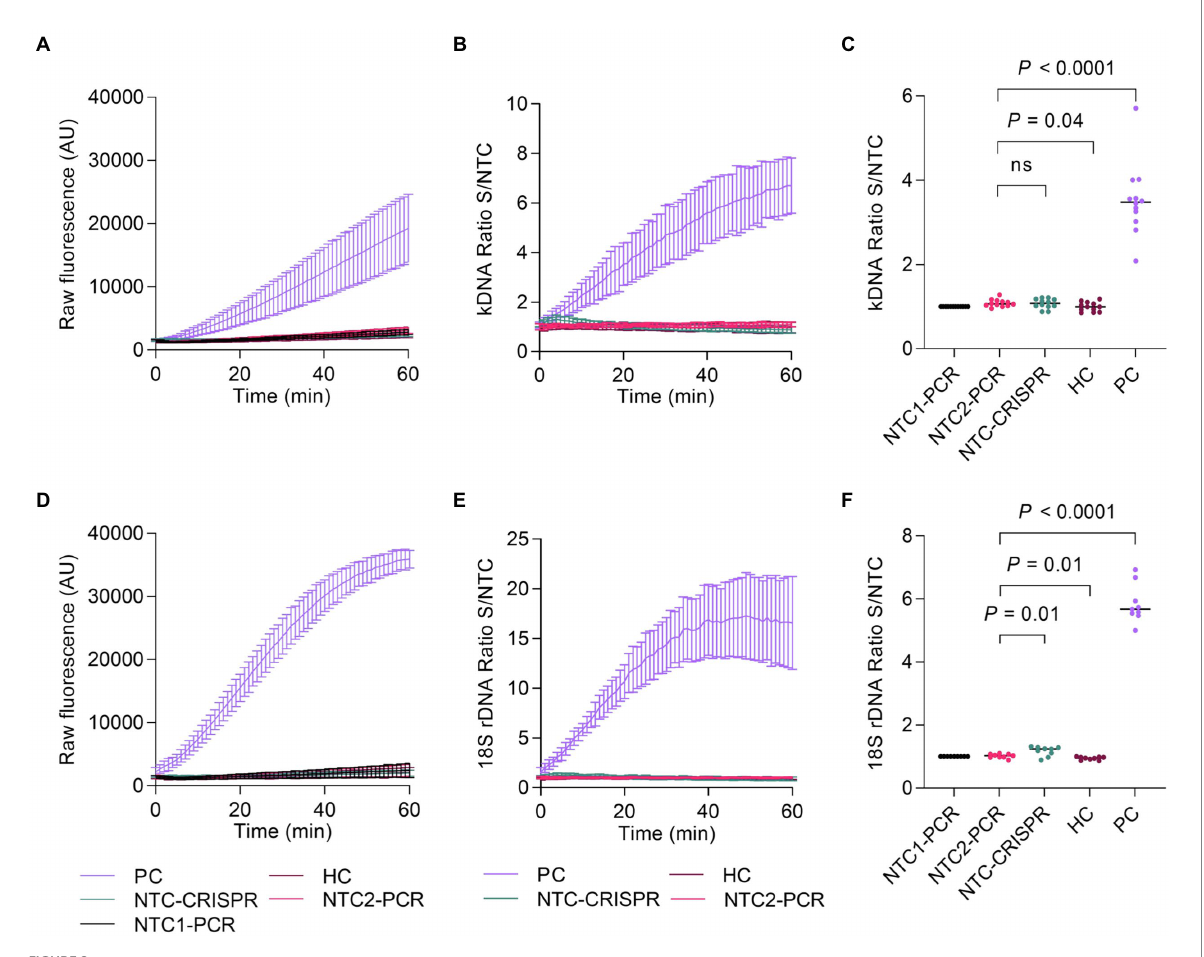
FIGURE 8 Assessment of PCR/CRISPR assay precision for detection of Leishmania targets. Measurements in independent experiments of the positive and negative controls (included alongside test samples) allowed to assess the intermediate precision (within-laboratory reproducibility) across PCR amplification and Cas12a-based detection runs. Fluorescence measurements taken on the Synergy H1 plate reader were considered for this analysis. The assays were performed by the same operator over a period of 5 months; two reagent batches of in vitro transcribed crRNAs were used. The positive control (PC) consisted of gDNA from L. ( V. ) braziliensis M2904 (5 × 10 4 parasite genome equivalents/reaction used as input DNA). The human negative control (HC) consisted of gDNA from PBMC of a healthy donor (40 ng of input DNA). Two NTC reactions were included in PCR runs to monitor for contamination: NTC1, kept closed without water addition [this control served for normalization of raw fluorescence values of the Cas12a reaction, expressed as a fluorescence ratio], and NTC2, made with water instead of the template. NTC-CRISPR, no-template control of the Cas12a reaction. (A) Raw fluorescence signal from the Cas12a reaction over 1 h for the kDNA target. Mean raw fluorescence values (arbitrary units, AU) ± SD are plotted as lines with error bars ( n = 12). (B) The data in (A) were normalized to the fluorescence of the NTC1 (PCR blank) and expressed as a fluorescence ratio. (C) The normalized data in (B) were used for detection analysis at the 20-min time point. (D) Raw fluorescence signal from the Cas12a reaction over 1 h for the 18S rDNA target. Mean raw fluorescence values (arbitrary units, AU) ± SD are plotted as lines with error bars ( n = 9). (E) The data in (D) were normalized to the fluorescence of the NTC1 (PCR blank) and expressed as a fluorescence ratio. (F) The normalized data in (E) were used for detection analysis at the 10-min time point. For (C,F) , pairwise comparisons